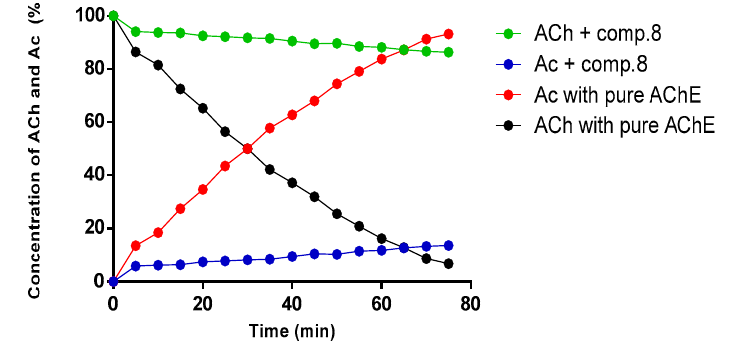
Figure 3. AChE inhibition by compound (8) using the NMR test.